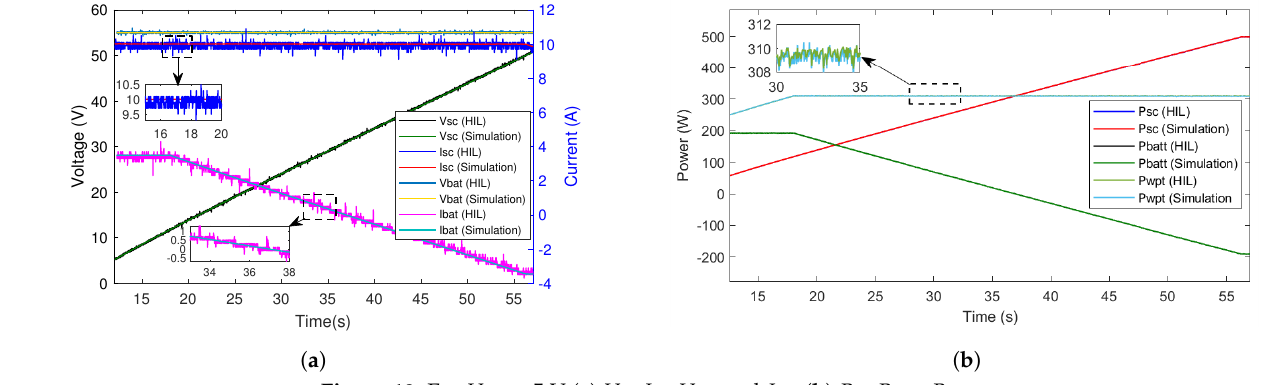
Figure 18. For V sci = 5 V ( a ) V sc , I sc , V bat and I bat ( b ) P sc , P wpt , P bat .